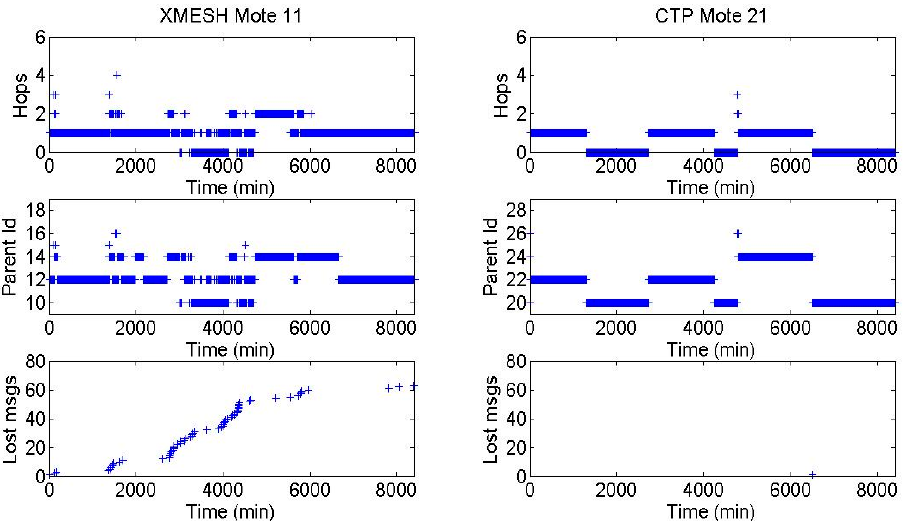
Figure 5. Number of hops, parent identifiers of each message, and total number of lost messages as a function of time using the XMESH (Mote 11) and CTP (Mote 21) protocols in Experiment 1.